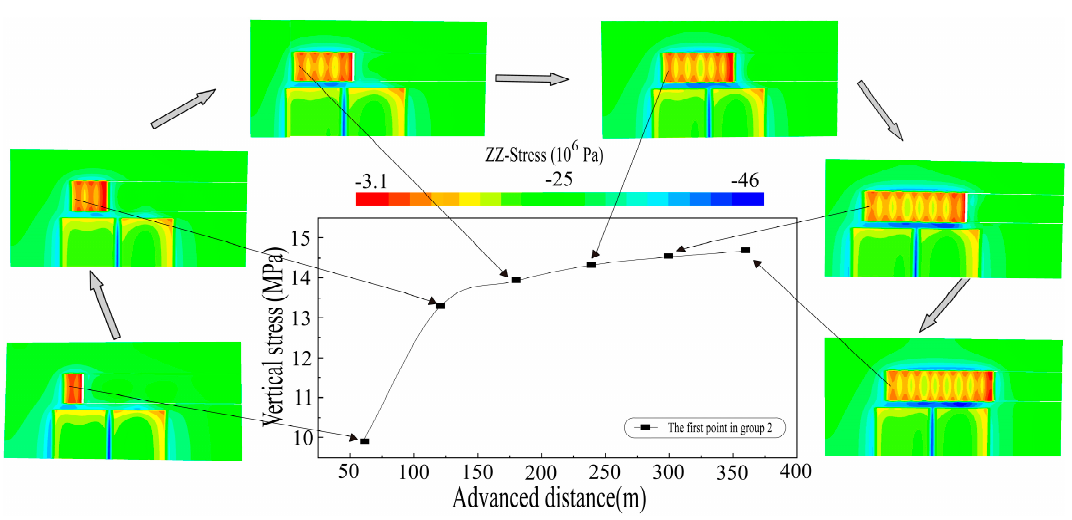
Figure 10. The change of the underground pressure over the process of mining.